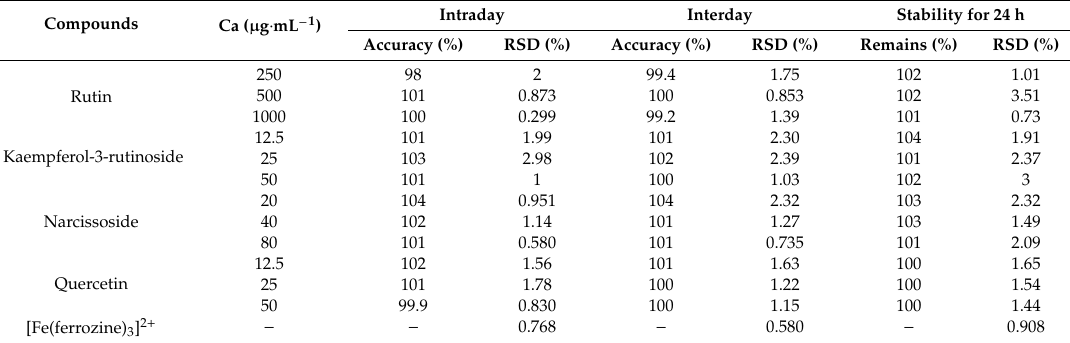
Table 5. Intra-day and Inter-day accuracy and precision, the stability of compounds. Ca is the actual concentration ( n =